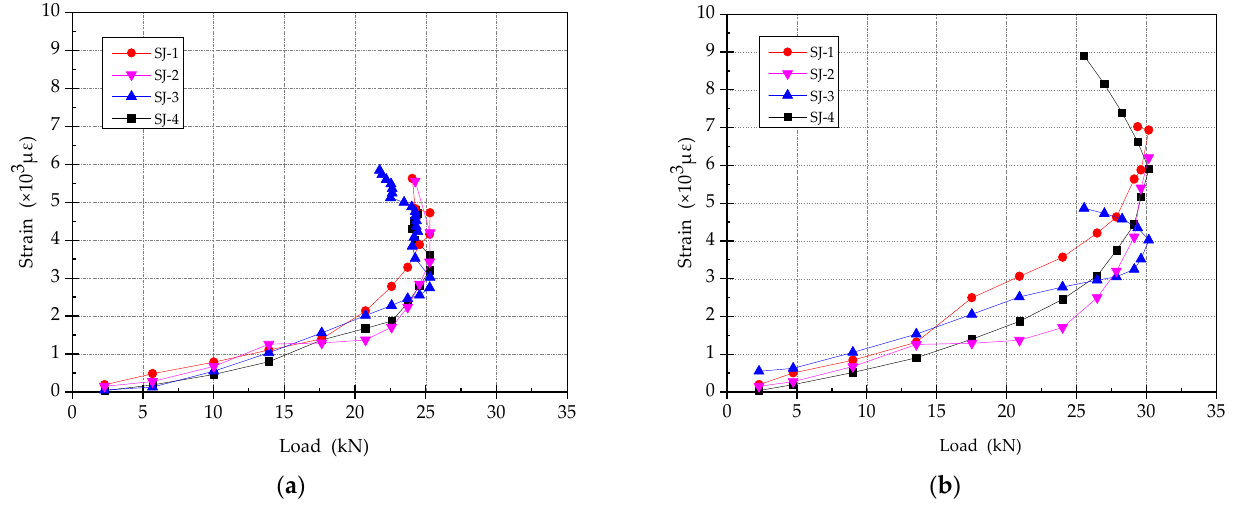
Figure 16. The load–strain relationship between the reinforcement. ( a ) The steel bar in existing beam section; ( b ) The reinforcements in enlarged section.